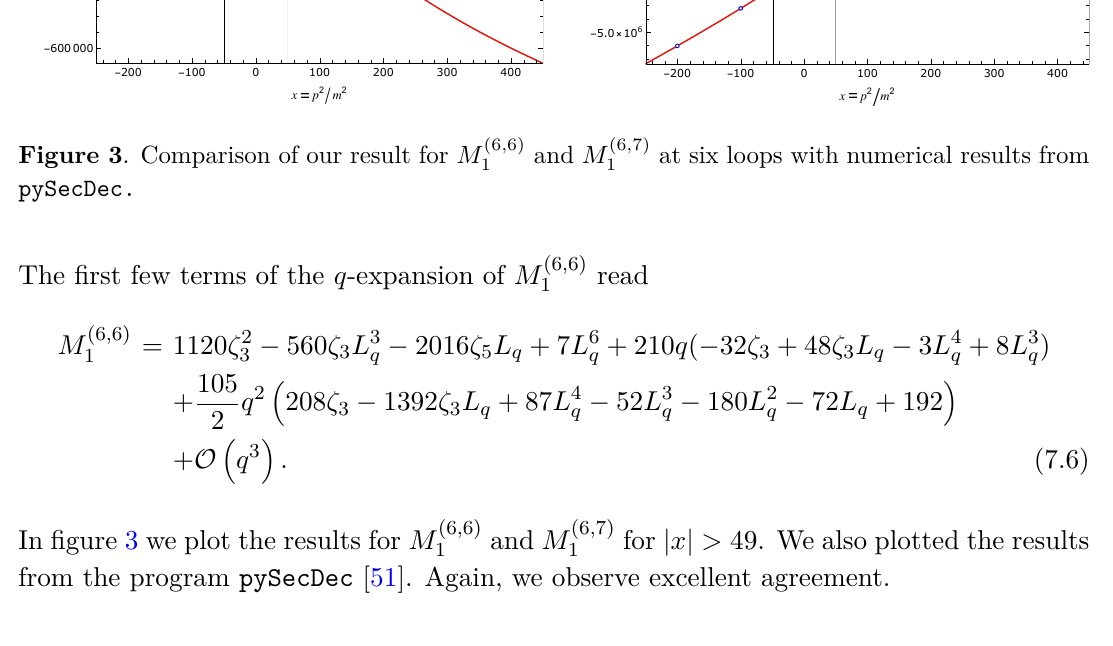
Figure 3 . Comparison of our result for M (6 , 6)